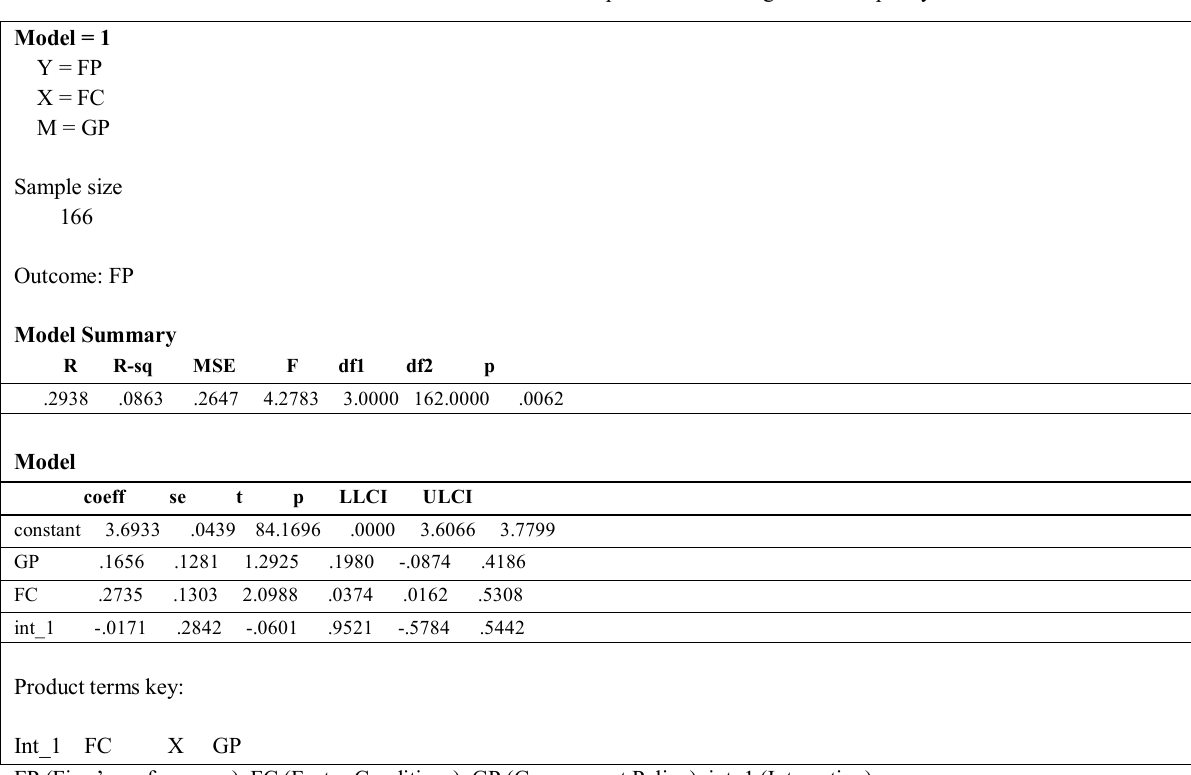
Table 5 : Influence of factor conditions on firm’s performance and government policy as